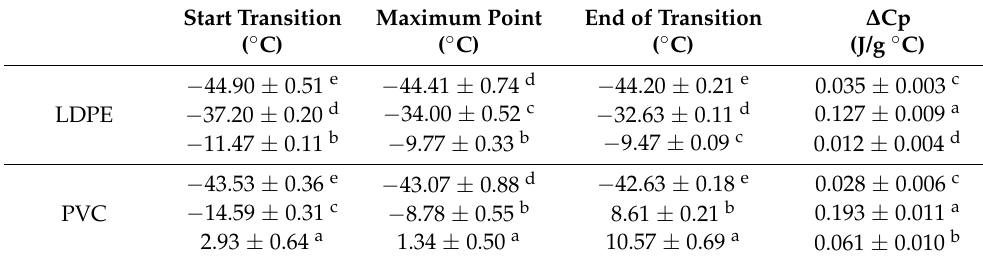
Table 3. Film transitions from − 45 to 20 ◦